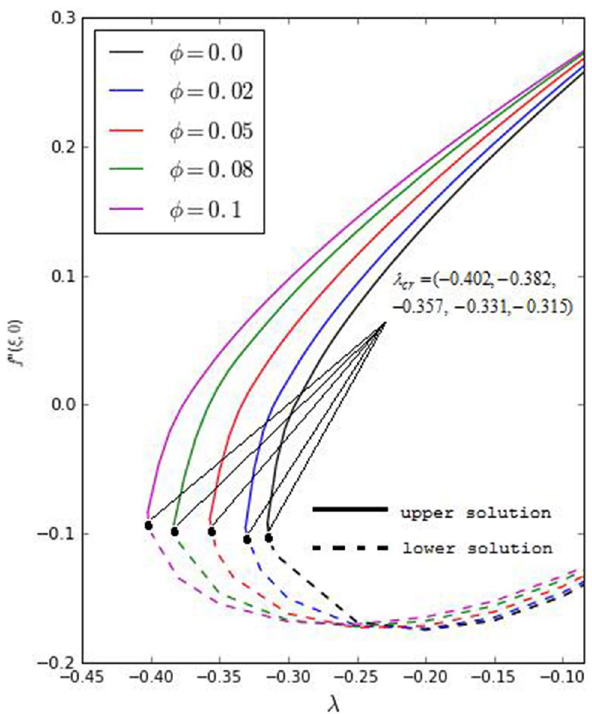
Fig. 4 Profiles for f �� ( 𝜉 ,0 ) for 𝜙 = 0,0.02,0.05,0.08 and 0.1 with fixed Pr = 6.7 for 𝜆 < 0